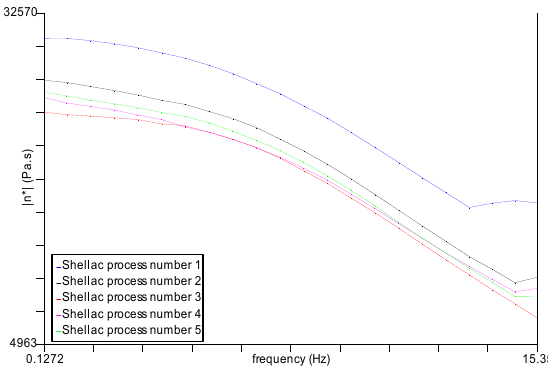
Figure 5. Complex viscosity ( η *) versus frequency (Hz) for each process run.